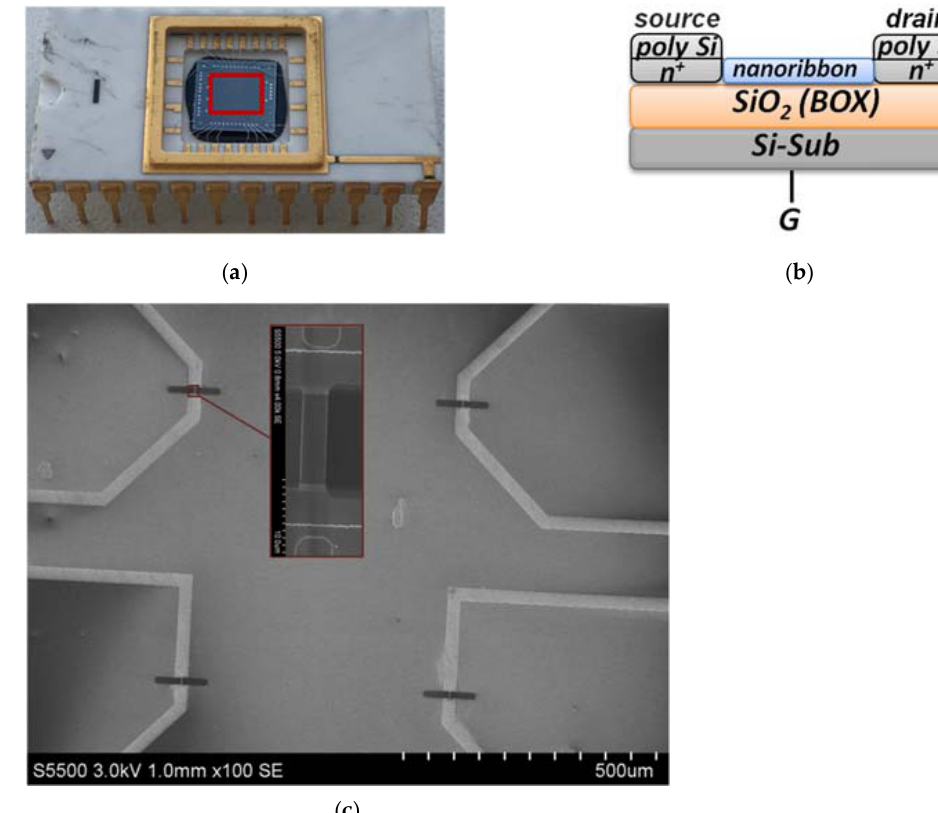
Figure 2. Photographic images of an assembled SOI-NR chip (top view), red square indicates the sensitive area ( a ); schematic representation of a cross-section of an individual SOI-NR with highly doped polysilicon source-drain contacts ( b ); SEM image of a section of the sensitive area of the SOI-NR chip, inset displays the SEM image of an individual NR ( c ).